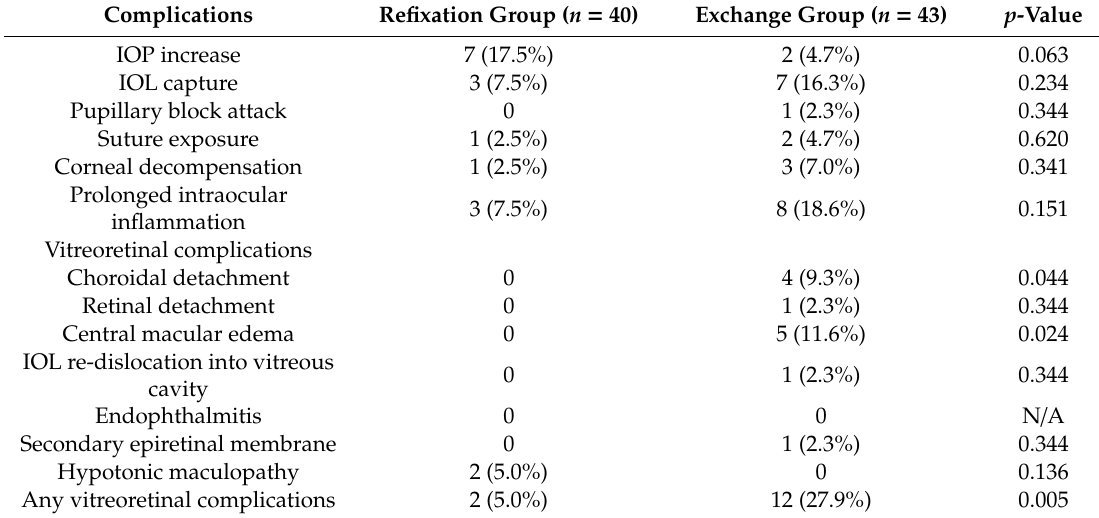
Table 3. Postoperative complications of the Refixation and Exchange